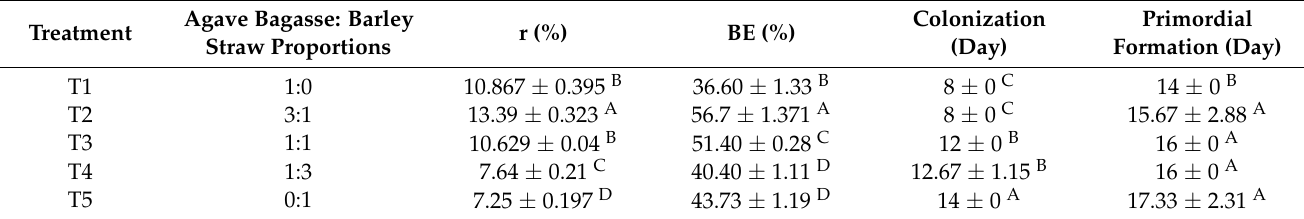
Table 1. Proportions of agave bagasse: barley straw of the substrates used for the cultivation, yield (r) %, and biological efficiency (BE)